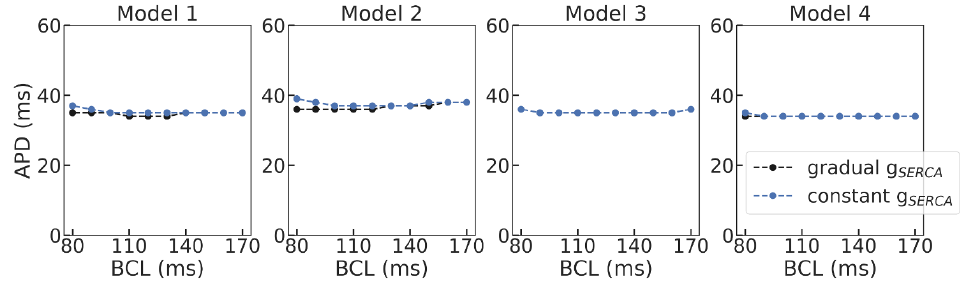
Figure A3. Comparison of APD restitution curves in the selected Gattoni2016 cellular models with gradual g SERCA depending on BCL (black lines), and at a constant g SERCA value assigned to 170 ms BCL (blue lines). The maximal difference between corresponding APDs is less than 3